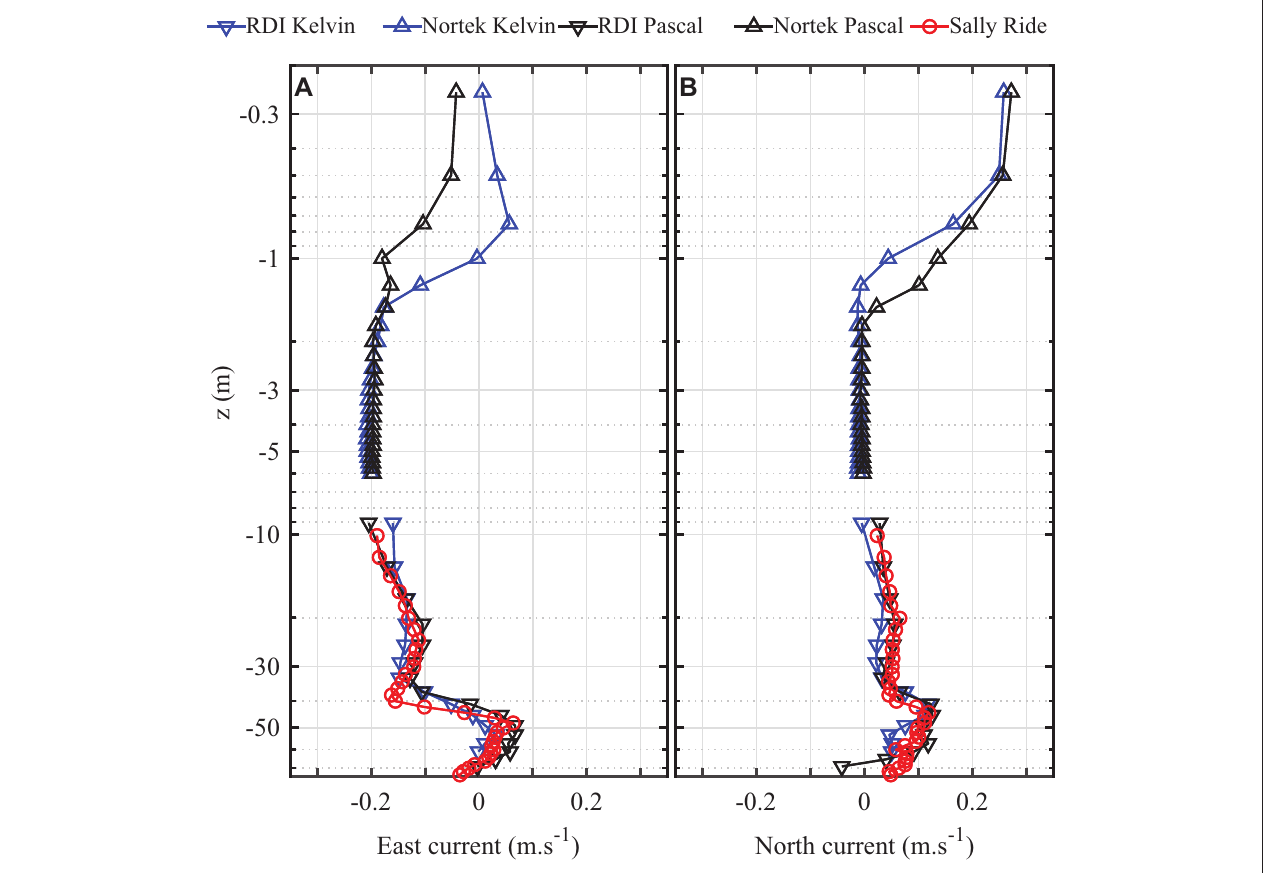
FIGURE 7 | Example of profiles of the (A) east and (B) north components of the current from both the SV2 Wave Gliders Kelvin (blue) and Pascal (black), and from the R/V Sally Ride (red) during the LCDRI2017 experiment. These profiles were averaged over a 30 min record starting at 0900 UTC 2 April 2017. The agreement between the three platforms is good as well as the continuity of measurements between the downward- (down triangle) and upward- (up triangle) looking ADCPs that are mounted on the Wave Gliders. Note that at the time of this particular record, the Wave Gliders were separated by 1.5